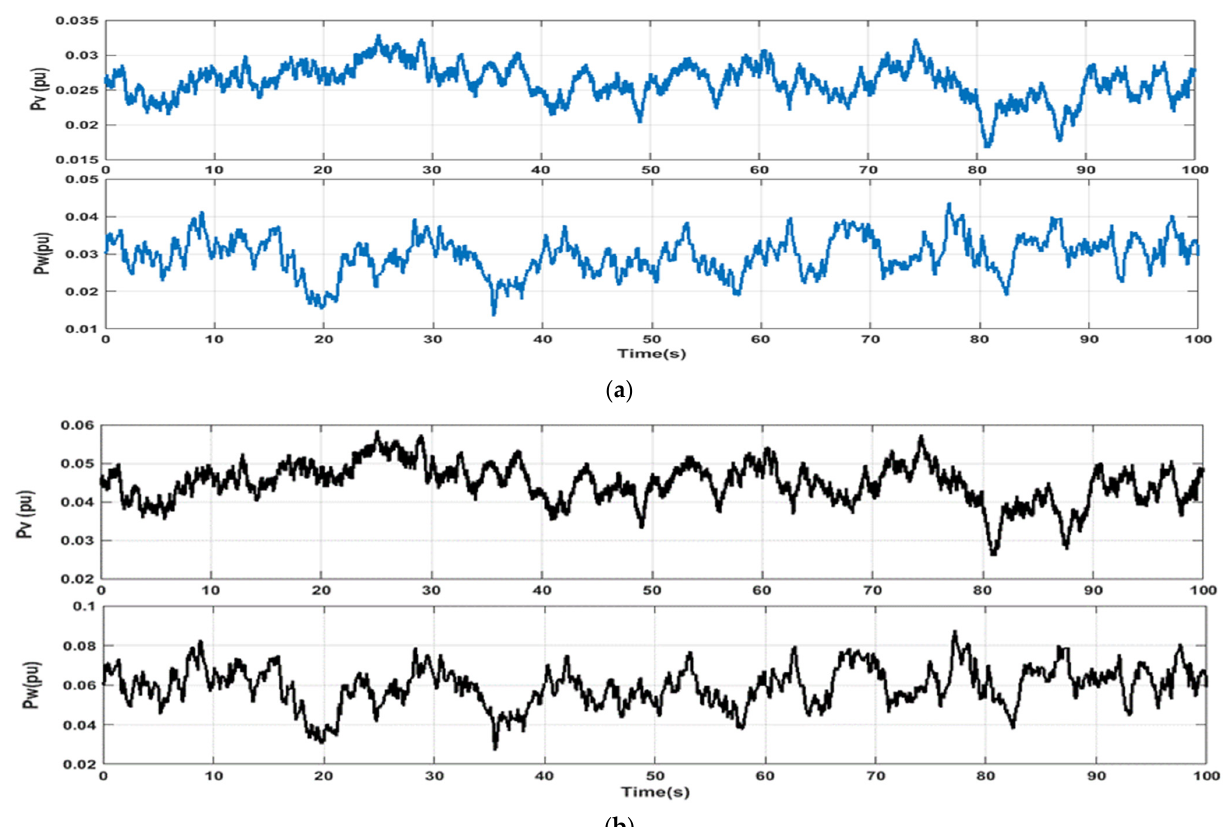
Figure 15. ( a ). The output of PV farm and wind farm in case of low renewables penetration. ( b ). The output of PV farm and wind farm in case of low renewables penetration.